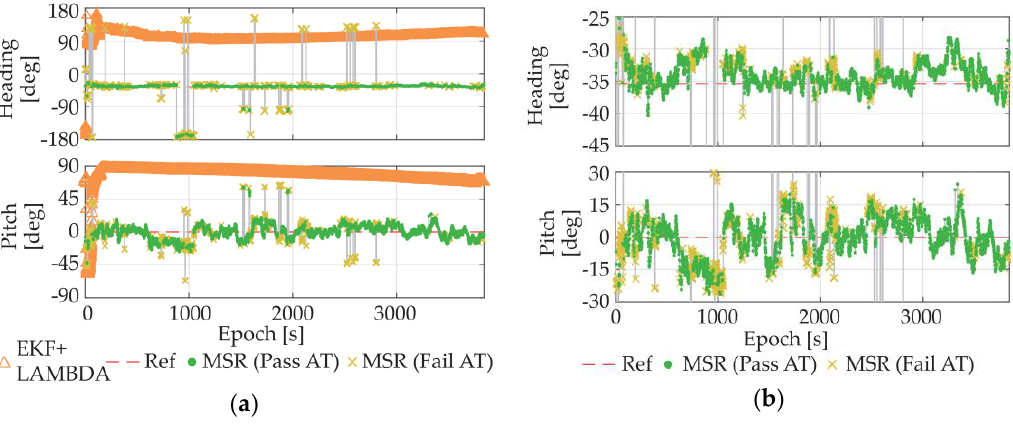
Figure 12. ( a ) Attitude results of LAMBDA+EKF and MSR; ( b ) Enlarged view of MSR results.